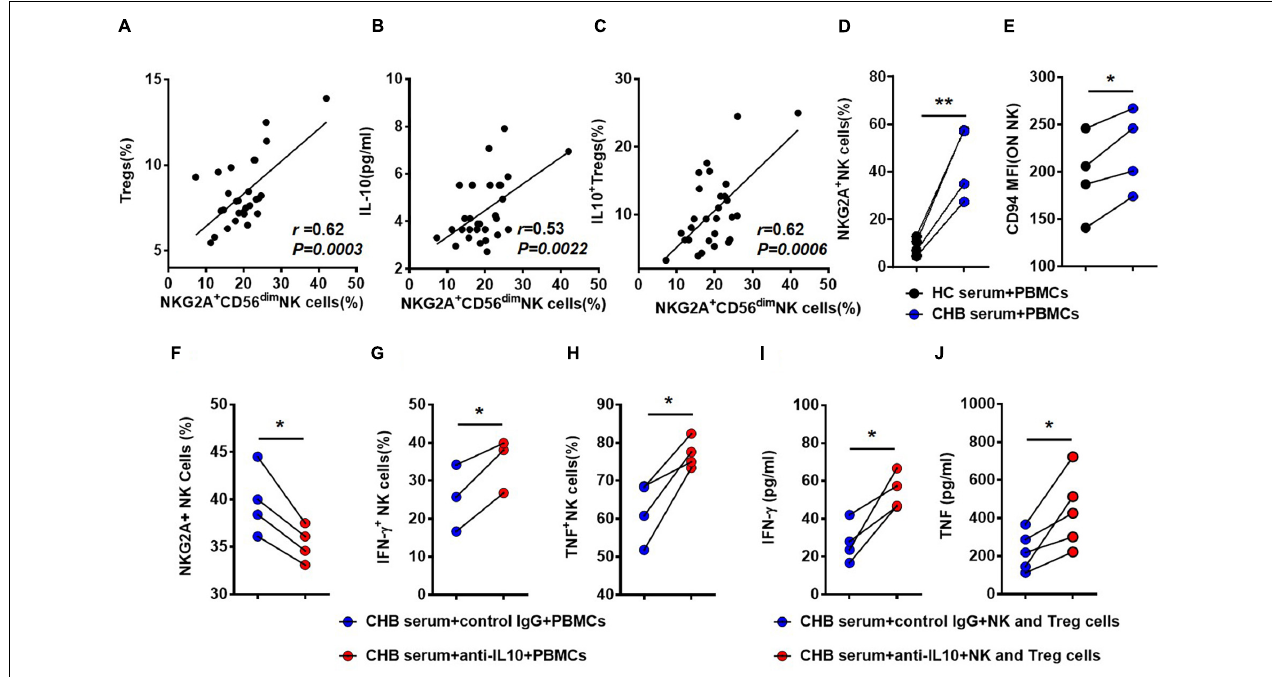
FIGURE 5 | Treg-derived IL-10 impairs NK cell function in patients with CHB. (A) Correlation between the percentage of NKG2A + CD56 dim NK cells and Tregs in patients with CHB determined by flow cytometry. (B) Correlation between the percentage of NKG2A + CD56 dim NK cells and serum IL-10 levels in serum samples from patients with CHB patients. (C) Correlation between the percentage of NKG2A + CD56 dim NK cells and IL-10 + Tregs in peripheral blood samples from patients with CHB. (D,E) PBMCs from healthy donors were cultured with 100 IU/ml IL-2 in the presence of 20% CHB or healthy control serum for 7 days. After 7 days of culture in the presence of 20% CHB or healthy control serum, expression of NKG2A and CD94 was monitored on NK cells by flow cytometry. (F–H) PBMCs from healthy donors were cultured with 20% CHB and 100 IU/ml IL-2 in the presence of 50 ng/ml anti-human IL-10 neutralizing antibody or control IgG. After 7 days, the percentages of NKG2A + NK cells, IFN- γ + NK cells and TNF + NK cells were detected after treatment of PBMCs with CHB serum and anti-IL-10 or control IgG in vitro . (I,J) NK cells (5 × 104) and Tregs (5 × 104) were purified from healthy donors and co-cultured in the presence of 20% CHB patient serum and 100 IU/ml IL-2, supplemented with anti-CD3 and-CD28 mAb, with 50 ng/ml anti-human IL-10 neutralizing antibody for 3 days. (I) The concentration of IFN- γ in the supernatant was measured using a CBA kit. (J) The concentration of TNF in the supernatant was measured using a CBA kit. Data are representative of more than three independent experiments. Results are presented as the mean ± SEM ( n ≥ 3 per group) and paired two-tailed Student’s t -tests or Spearman’s correlation coefficients were conducted; * p < 0.05; ** p <